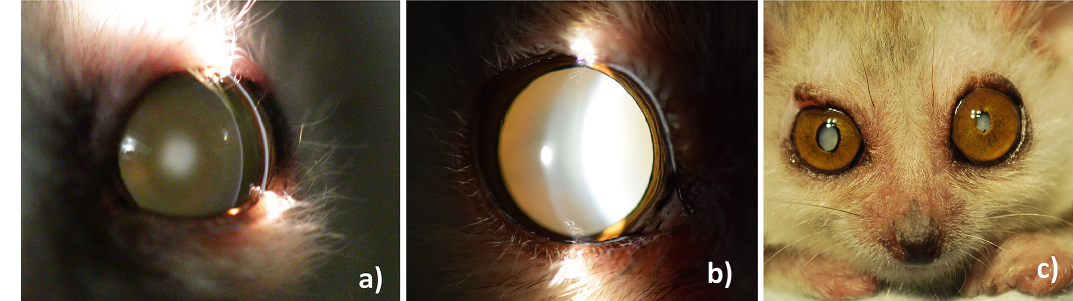
Figure 4. Typical development of age-related ocular changes in mouse lemurs. (a) A 3-year old animal with nuclear sclerosis, (b) an 8-year old animal with mature cataract, (c) a 12-year old animal with both lenses affect by mature cataracts. The right eye shows additional partial iris posterior synechia, the left eye shows pupil seclusion.